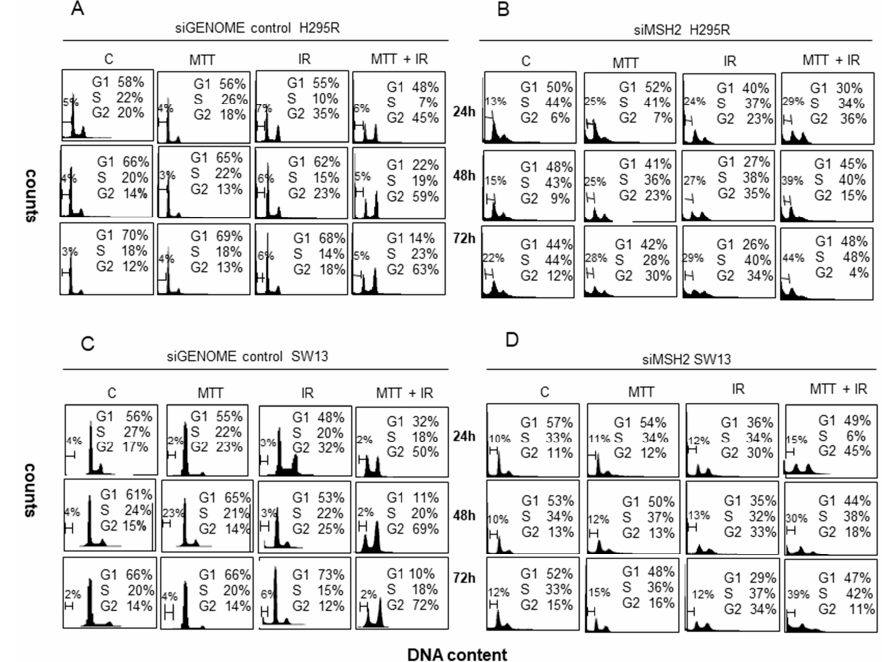
Figure 6. MSH2 interference in both the H295R and SW13 adrenocortical cell lines. The cell cycle was evaluated by PI staining and flow cytometry (FCM) analysis in H295R and SW13 cells